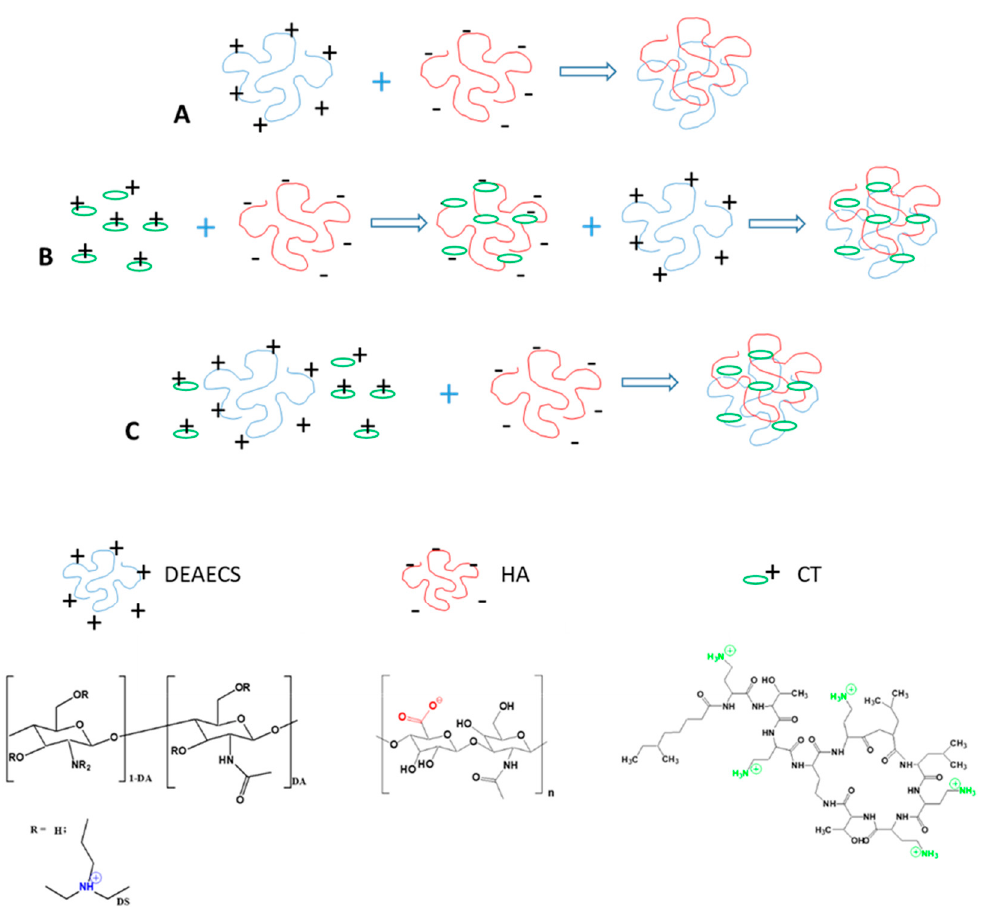
Table 1. Formation parameters and properties of HA-DEAECS and CT-HA-DEAECS PECs (mean ± standard deviation, n = 3). No. Formulation (Weight Ratio)